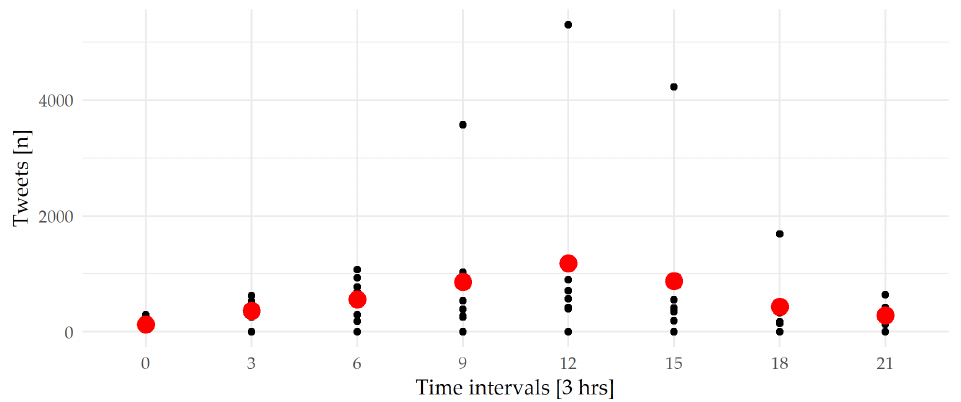
Figure 7. Time-of-day effect of the dataset on a subtler temporal scale. The overlaid red dots predict the linear modelled trend of that daily activity pattern.